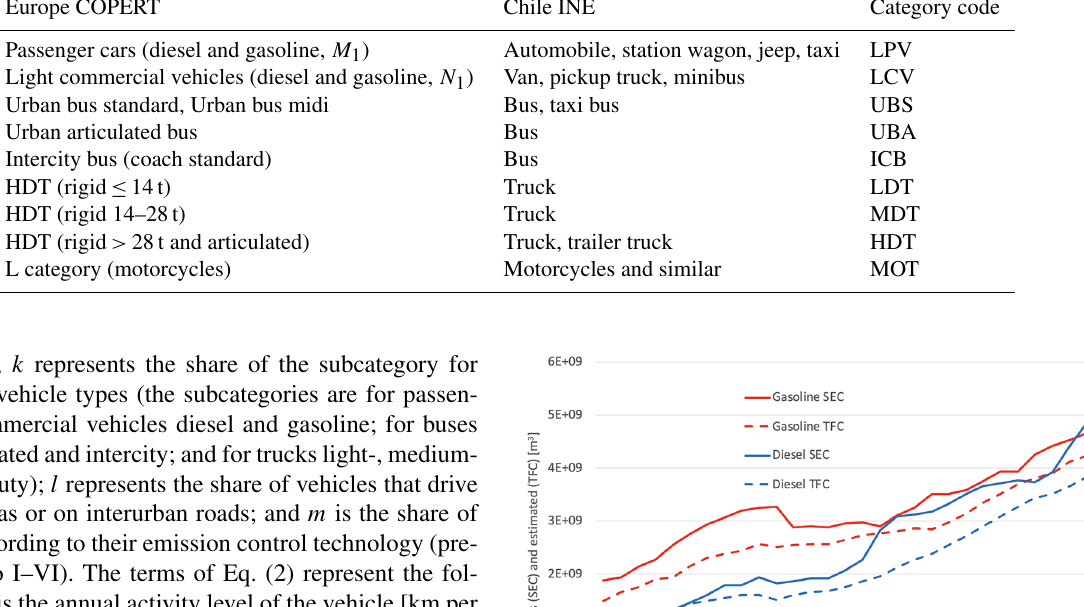
Table 1. Equivalence of European and Chilean main vehicle categories. HDT denotes heavy-duty truck. Europe COPERT